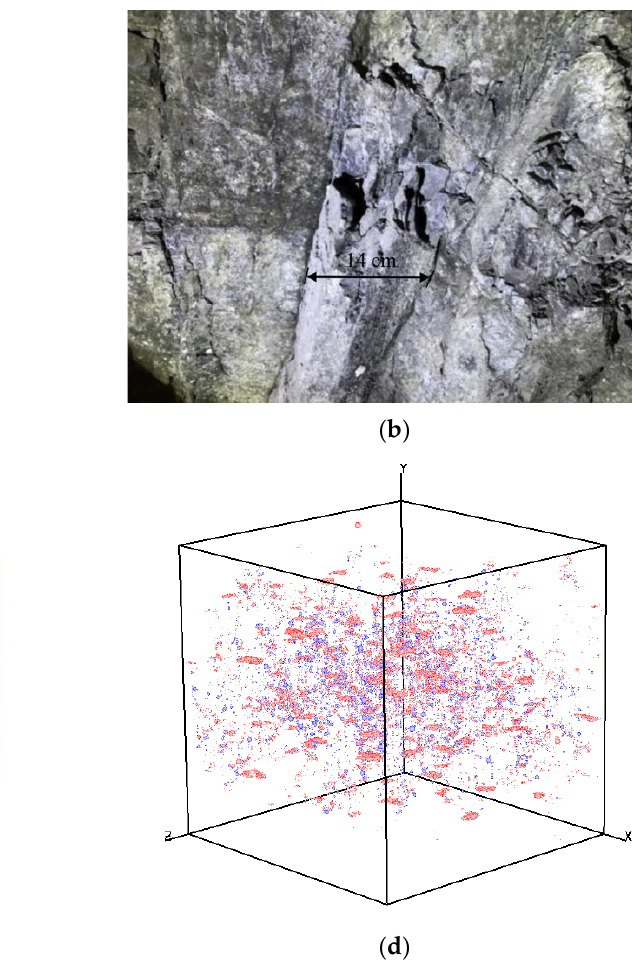
Figure 17. Comparisons of CJRM failure modes between the numerical specimen and the in-situ specimen. ( a , b ) The fracture mode of the in-situ specimen; ( a ) is the top view, and ( b ) is the front view [7]. ( c ) The fracture mode of the numerical specimen. ( d ) The spatial distribution of acoustic emission (AE) events.